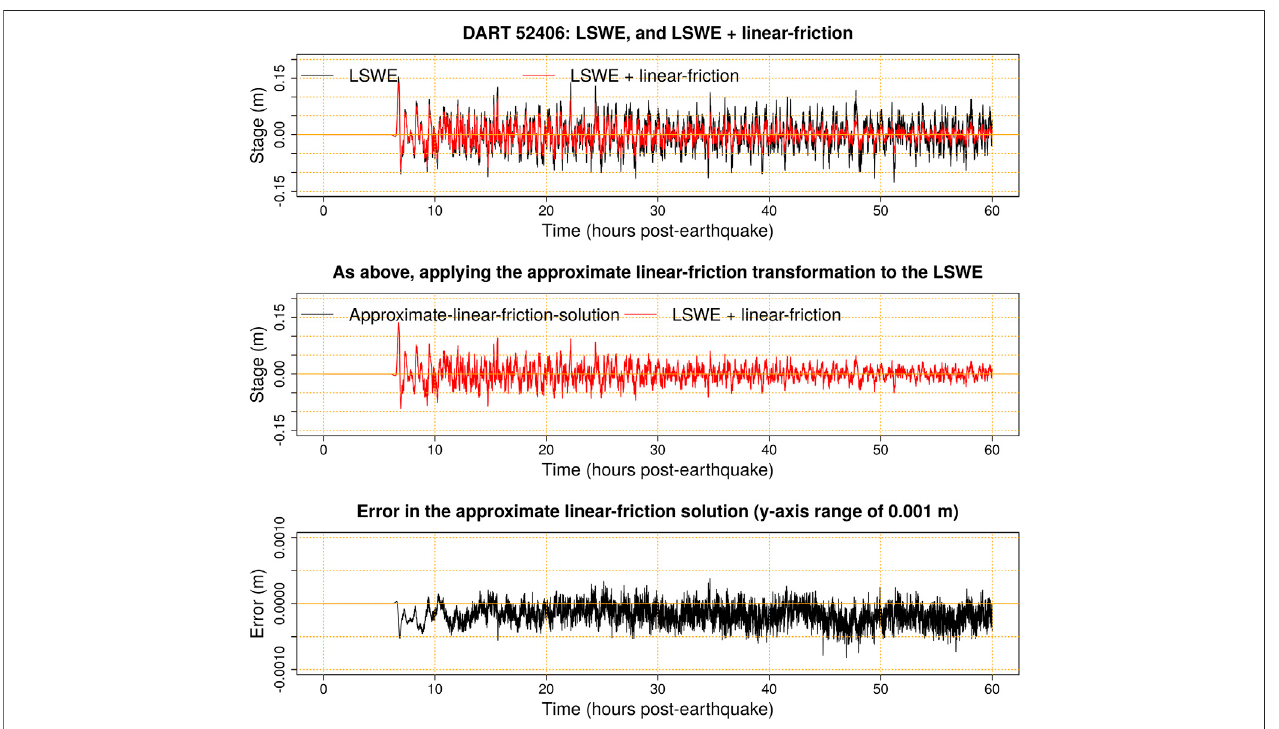
FIGURE6| Illustrationoftheapproximatelinear-frictionsolutionatadeepoceansite(DART52406),usingtheY18source.Top:Comparisonofnumericalsolutions using the frictionless LSWE ( Section 2.4.2 ) and the LSWE with constant linear-friction ( Section 2.4.4 ). Middle panel: Comparison of the approximate linear-friction solution (derived with the LSWE solution via Eq. 10 ) and the LSWE with constant linear-friction. They are visually indistinguishable. Bottom: Difference between the two solutions in the middle panel, using a vertical scale of ± 0 . 001 m.